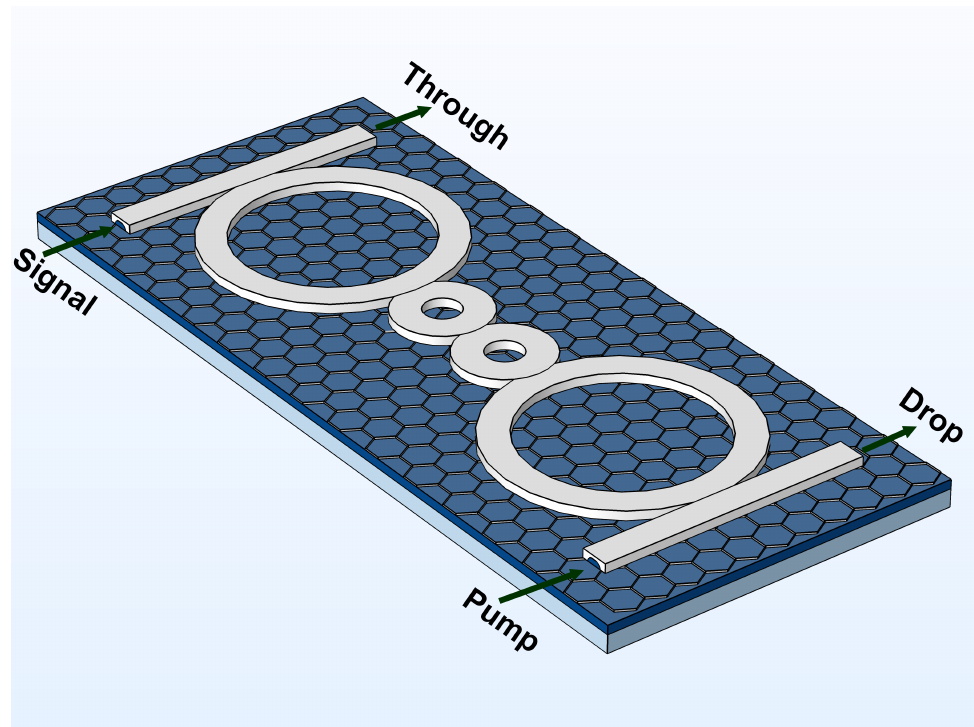
Figure 1. 3D Schematic of the filter model. The signal is injected through the input port. Only the resonant wavelengths are coupled in the ring resonators and propagate through the filter and exit at the drop port. The rest exit the filter using the through port. The pump (control) signal is injected in the filter through the add